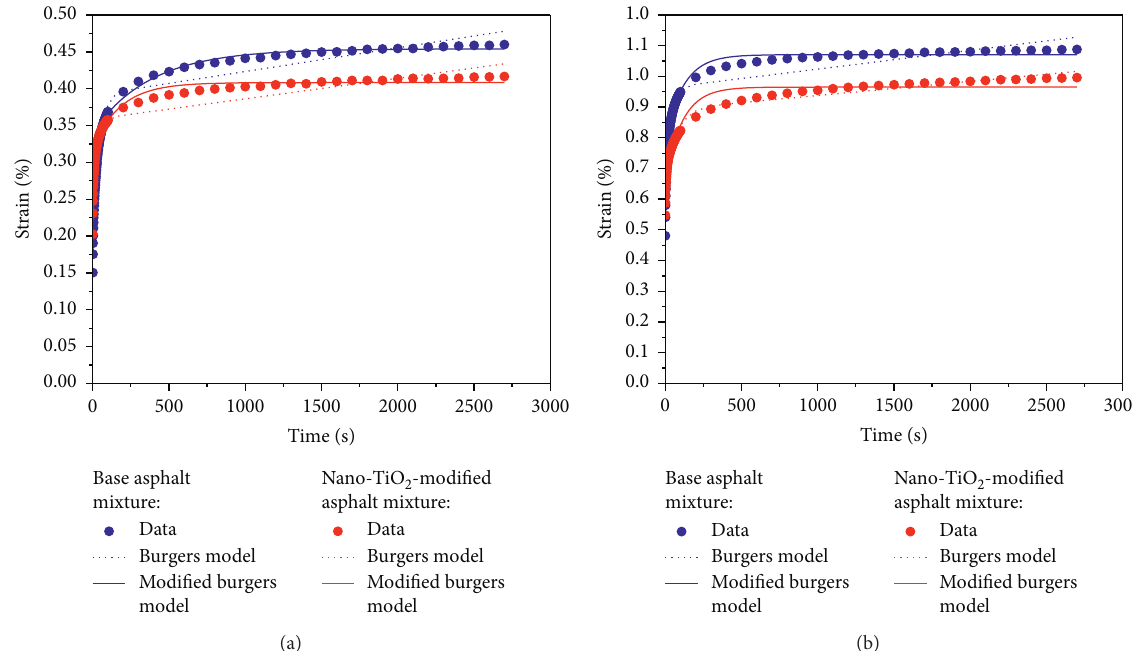
Figure 10: Comparative results of the Burgers’ model and modified Burgers’ model for asphalt mixtures versus time. (a) 20 ° C. (b) 50 °